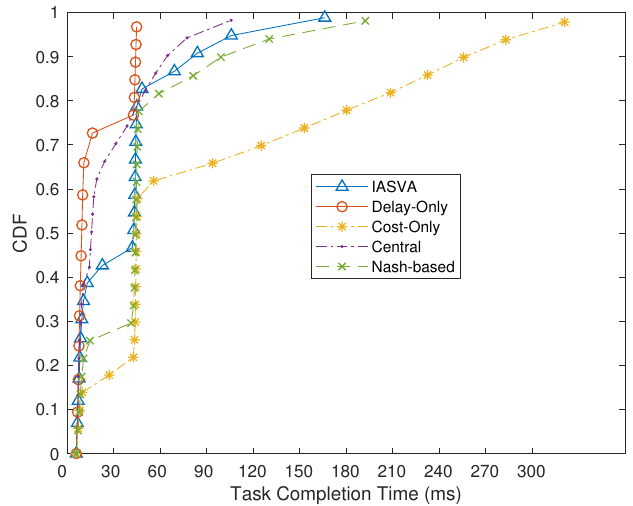
Figure 4. Task-completion time of four strategies.